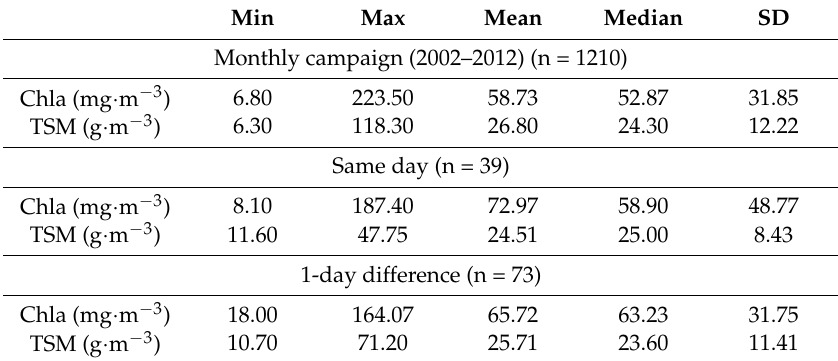
Table 1. Descriptive statistics of water quality parameters measured at Lake Kasumigaura. Monthly campaign refers to in situ measurements that were performed every month from May 2002 to May 2012. Sam- day and 1-day difference datasets represent in situ measurements that synchronized the acquisition dates of MERIS images on the same day or with a one-day difference,